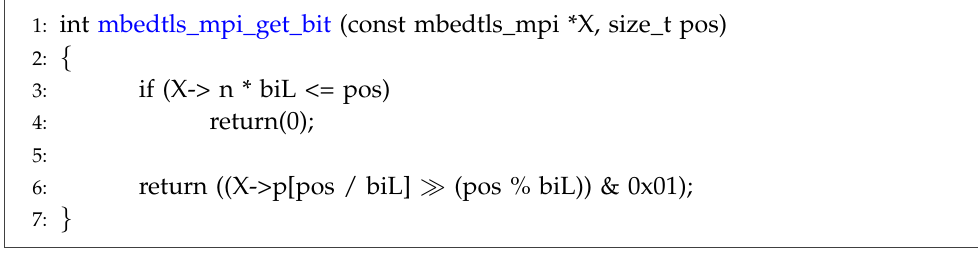
Figure 11. Software implementation (mbedTLS): acquisition